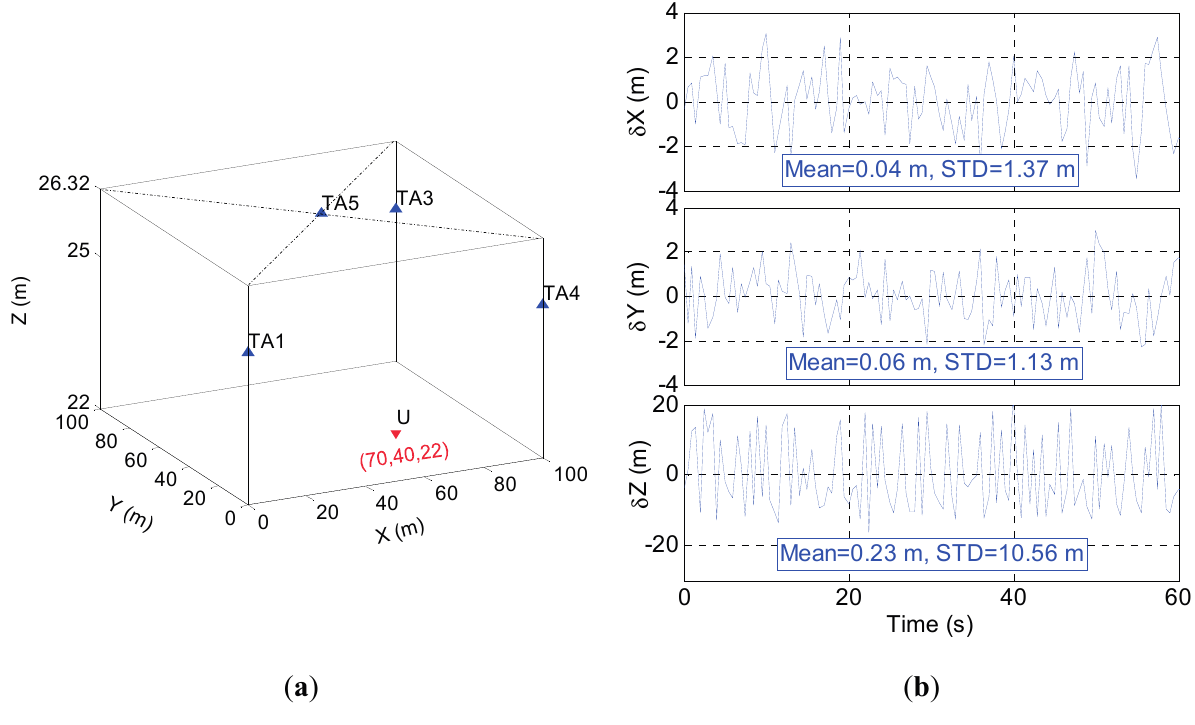
Figure 10. Distribution of TA for 3-D positioning test and its positioning error: ( a ) TA distribution; and ( b ) positioning